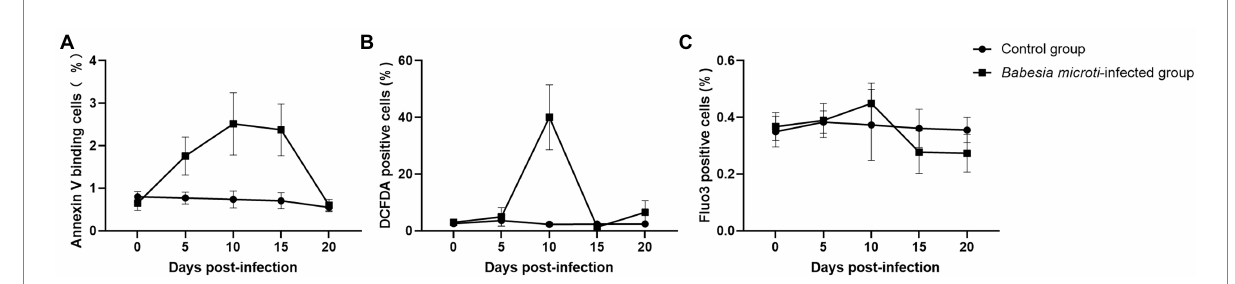
FIGURE 2 Eryptosis assays after B. microti infection. Line graphs showing that (A) B. microti induced more PS exposure to the cell surface of erythrocytes, (B) ROS levels in the erythrocytes were higher in the B. microti -infected group at 10 dpi, and (C) Calcium ion activity of erythrocytes increased slightly in B. microti -infected group at 10 dpi, but not significantly. The results are expressed as the mean percentage of positive cells ± the standard deviation (SD) from five